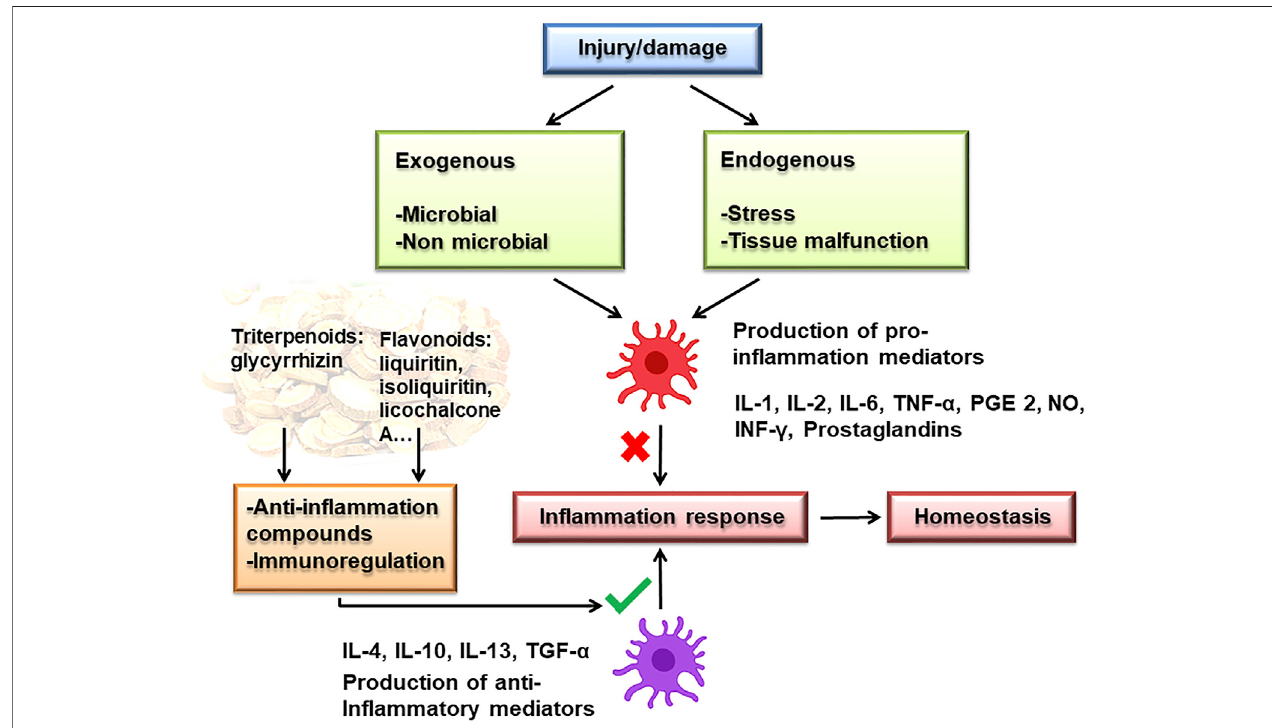
FIGURE 3 | Anti-in fl ammatory mechanism of